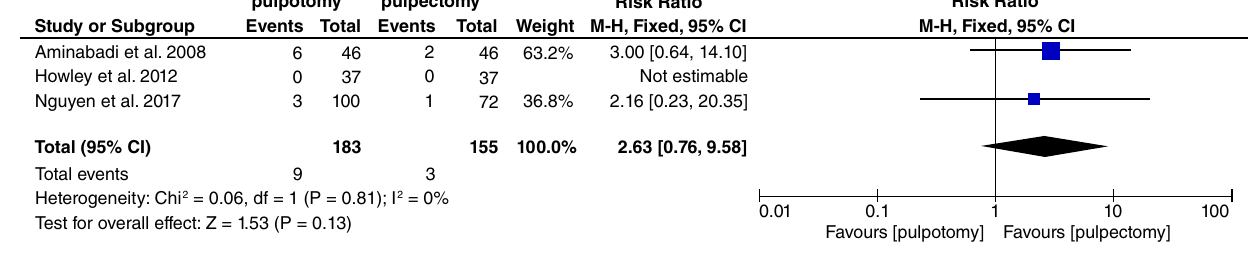
Figure 3. Meta-analysis for clinical failure.